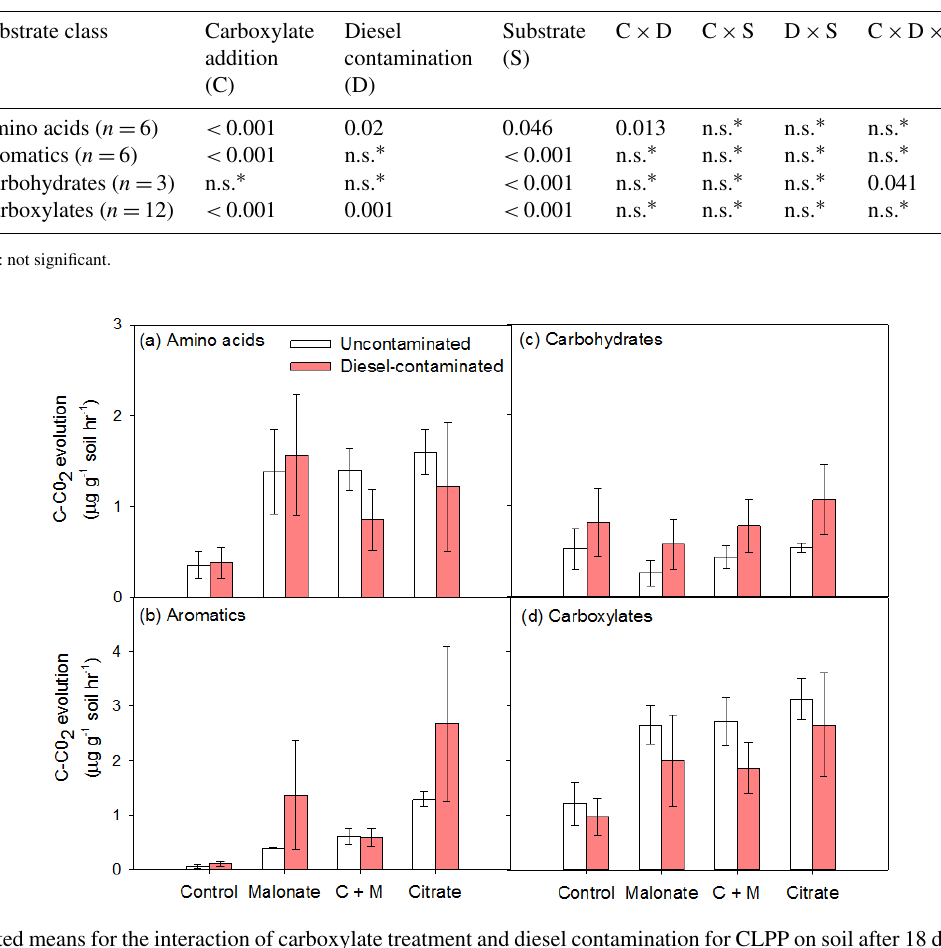
Figure 3. Estimated means for the interaction of carboxylate treatment and diesel contamination for CLPP on soil after 18 days of incubation for diesel-contaminated and uncontaminated soils which received water or 5µmolg − 1 soil of malonate, citrate + malonate, or citrate every 48h and was mixed with 27 substrates from four main classes (amino acids ( n : 6 substrates), aromatics ( n : 6 substrates), carboxylates ( n : 12 substrates), carbohydrates ( n : 3 substrates)). Values are means ± SEM ( n : 3). Statistical outcomes are presented in Table